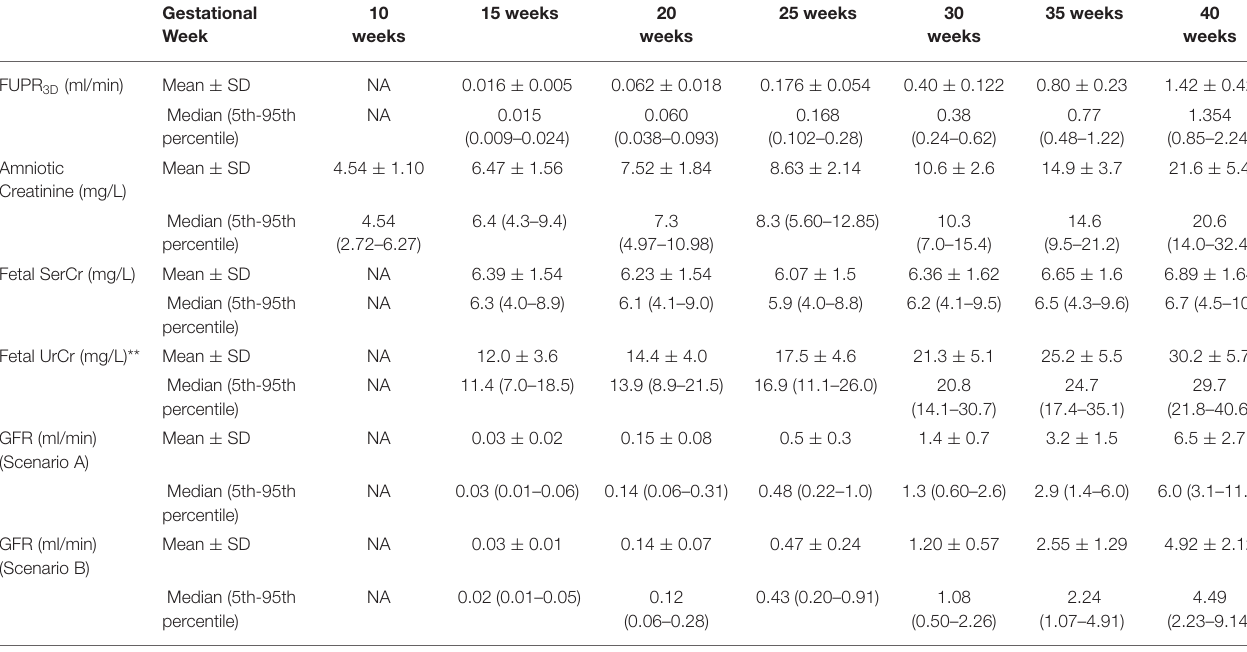
TABLE 3 | Predicted values for fetal urine production rate (FUPR), creatinine level and GFR at different gestational weeks. Gestational